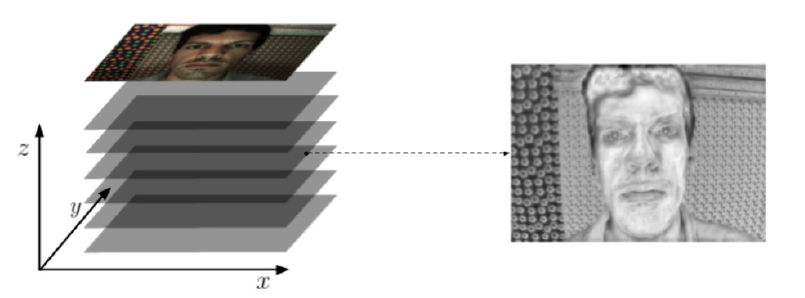
Figure 10. Representation of a cost volume, where light colors represent less probability that the points are at this depth.